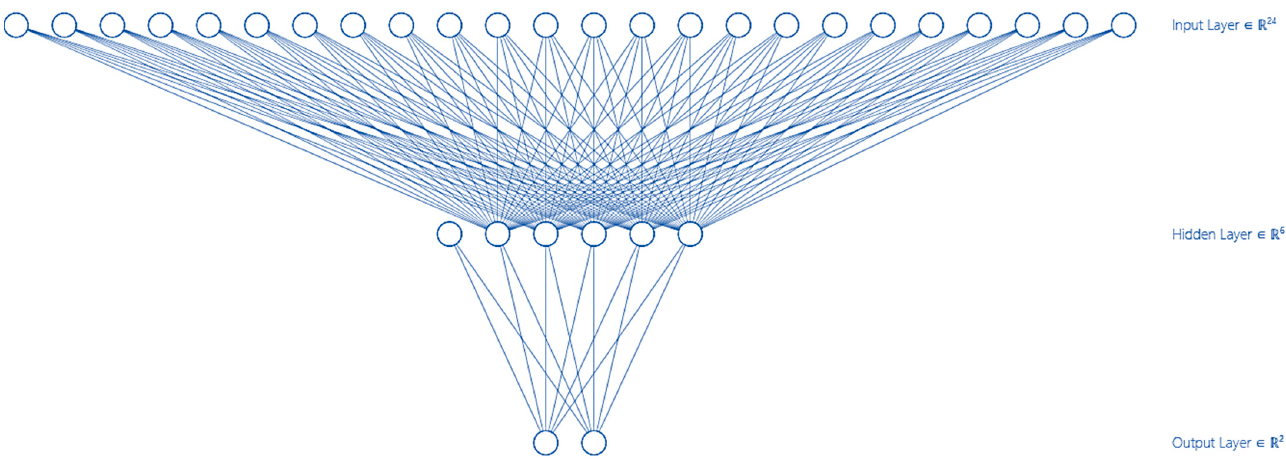
Figure 1. ANN3 architecture; Source: Author’s work, https://alexlenail.me/NN-SVG/index.html (accessed on 5 August 2022).